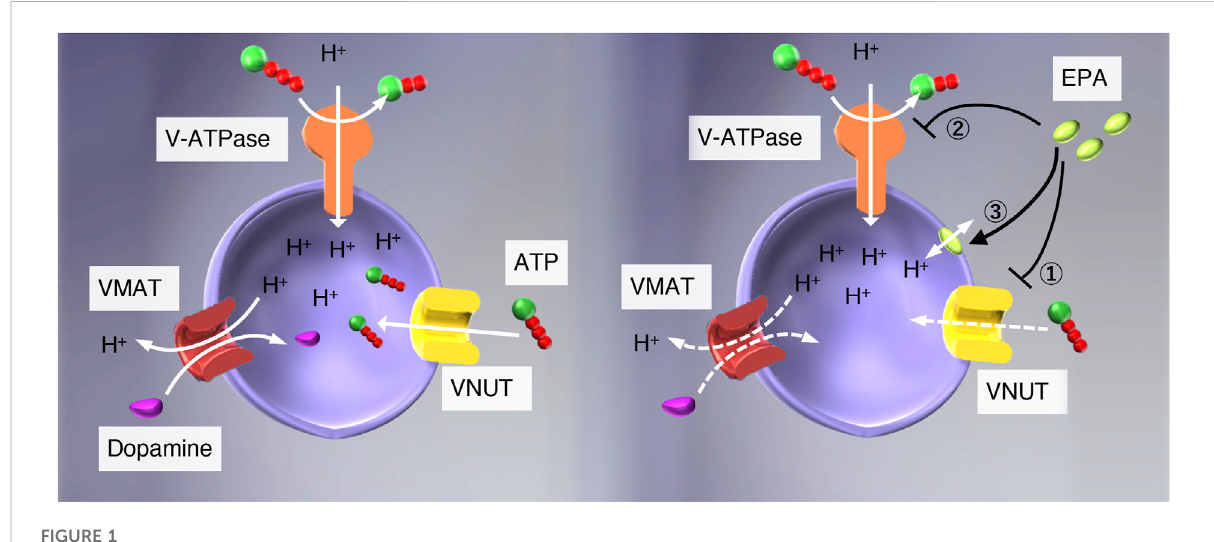
FIGURE 1 Possible modes of action of EPA in the vesicular storage of ATP. ( left ) V-ATPase pumps protons upon hydrolysis of ATP and establishes an electrochemical gradient of protons across the vesicular membranes, and drives storage of monoamine and ATP. ( right ) EPA may interact with 1) VNUT,2)V-ATPase,or3)vesicularmembranes.IftheinteractionbetweenEPAandVNUTisspeci fi c,EPAwillnotaffecttheATP-dependentformation of Δ pH, Δψ , and ATP-dependent dopamine uptake in chromaf fi n granule membranes. ATP-dependent L-glutamate uptake in synaptic vesicles would be unaffected as